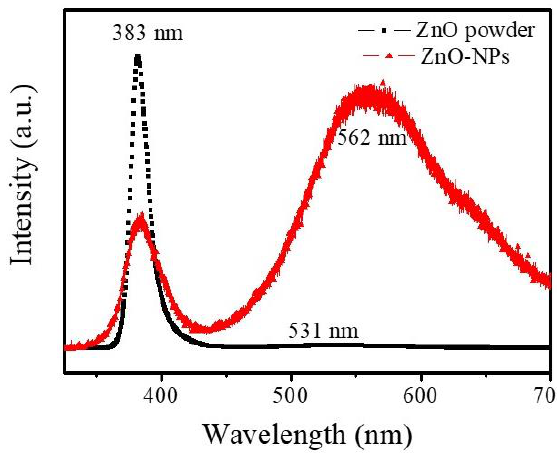
Figure 8. The room temperature photoluminescence spectrum for origin-ZnO powder and ZnO-NPs on glass.